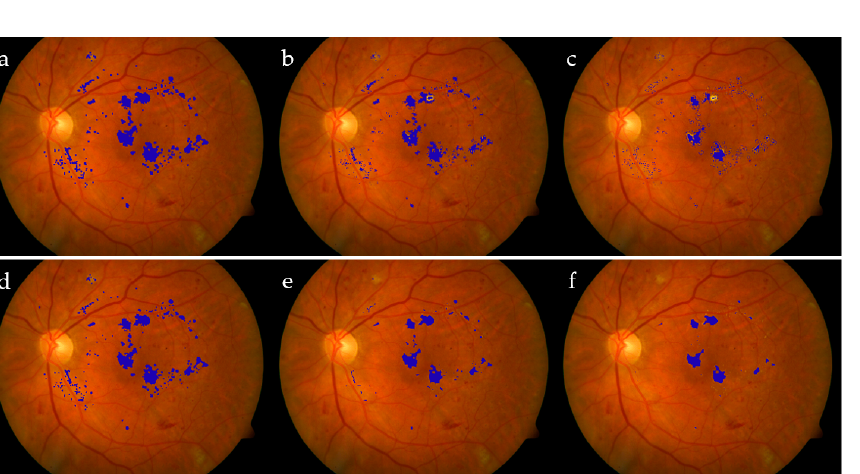
Figure 12. Dilating extracted exudates around the OD: without dilation ( a , b ) and with dilation, using SE = 45 ( c , d ).